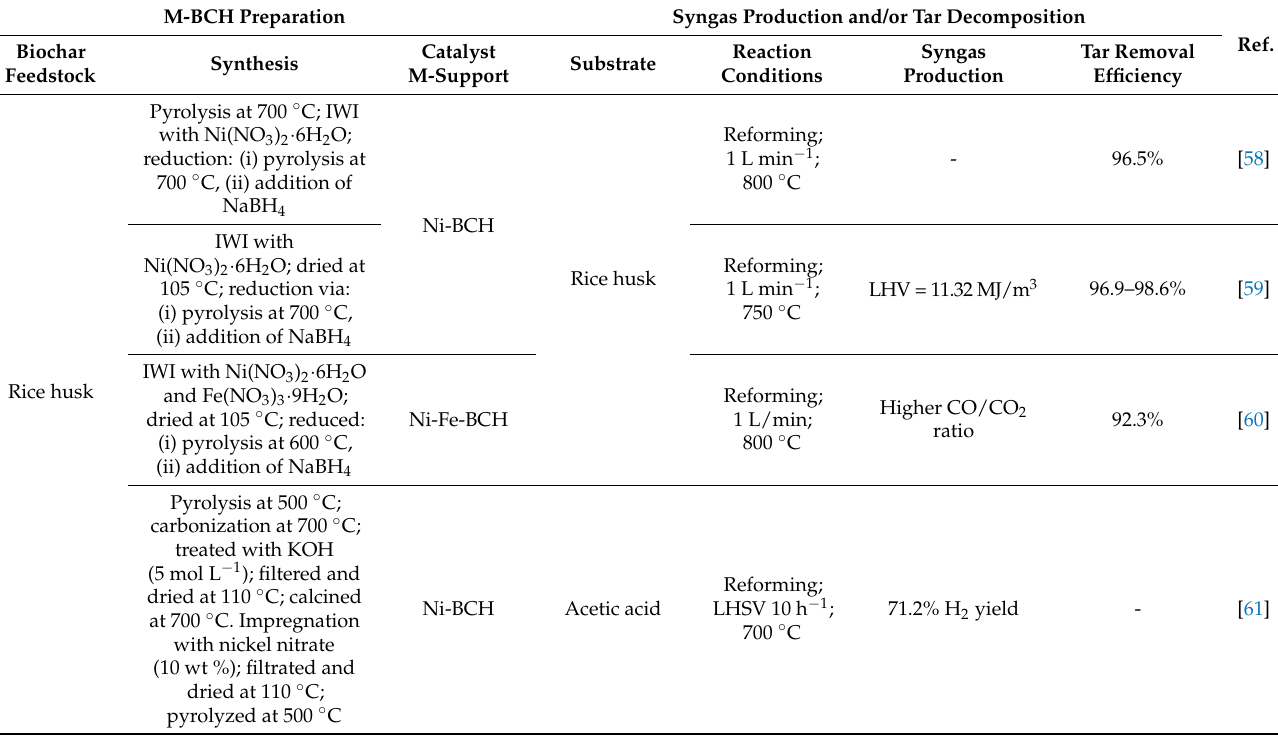
Figure 4. Main chemical transformations during biomass conversion in a gasifier. With permission of [57]. Copyright Clearance Center Inc. (2010). Table 3. Metal-supported biochar-based catalysts used in reforming/gasification reactions for syngas production and/or tar